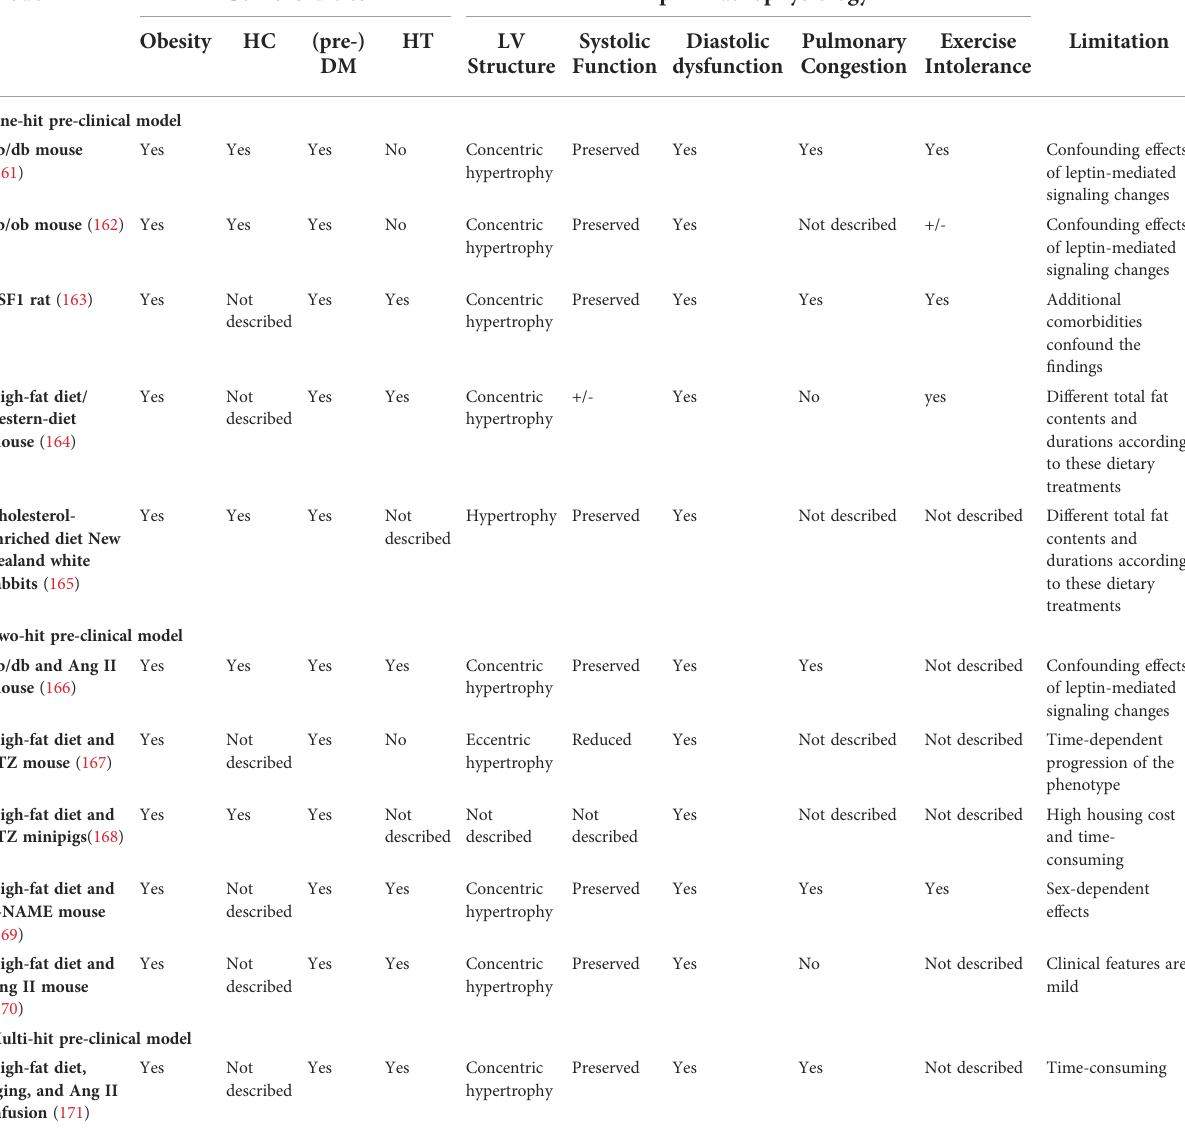
TABLE 1 Pathophysiology characteristics of Obese HFpEF animal